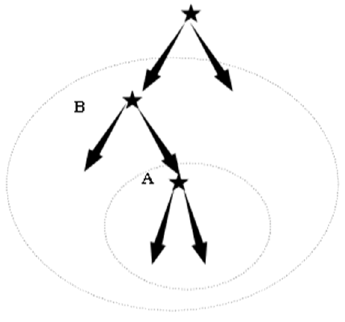
Figure 4. The sub-tree of the game tree.